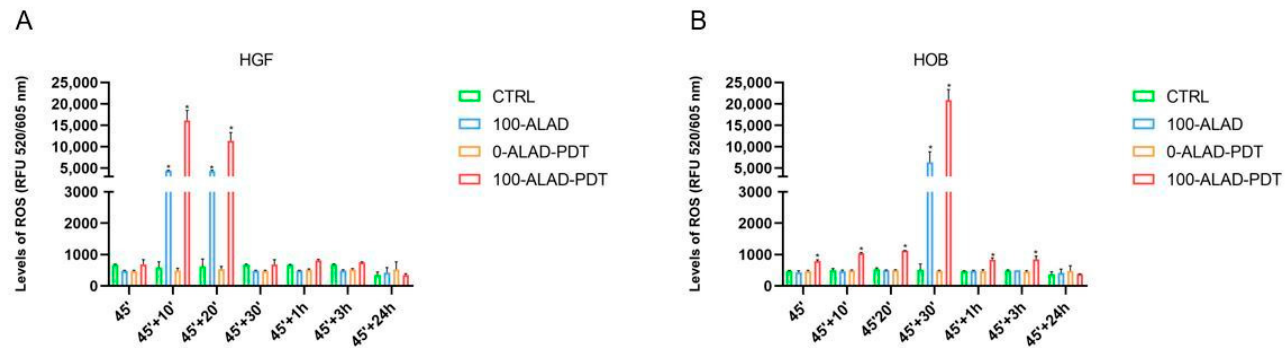
Figure 6. Levels of ROS. The quantification of ROS was measured after the ALAD-PDT protocol at the end of the treatment (45 ′ ), at 10 min (45 ′ + 10 ′ ), at 20 min (45 ′ + 20 ′ ), at 30 min (45 ′ + 30 ′ ), at 1 h (45 ′ + 1 h), at 3 h (45 ′ + 3 h), and at 24 h (45 ′ + 24 h). Data are reported as mean ± SD of three independent experiments and expressed in the relative fluorescent unit (RFU), measured at λ ex/em 520/605 nm. The largest increment was observed after 10 ′ for HGF ( A ) and 30 ′ for HOB ( B ). The statistical analysis was performed by ANOVA test comparing each value to its control (* p < 0.0001).